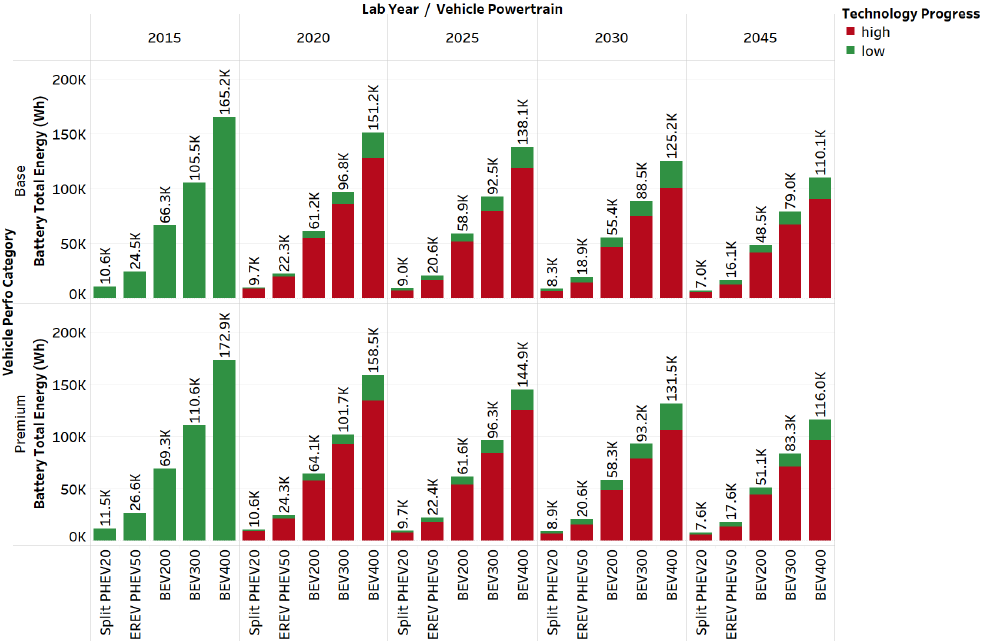
Figure 9. Total battery energy for midsize